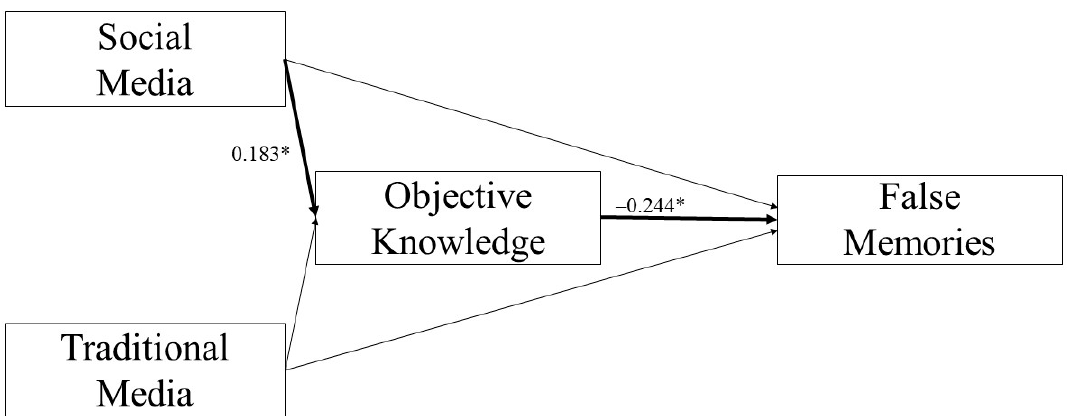
Figure 2. Scheme of the mediation effect of objective knowledge in the relationship between social media and false memories (* p <